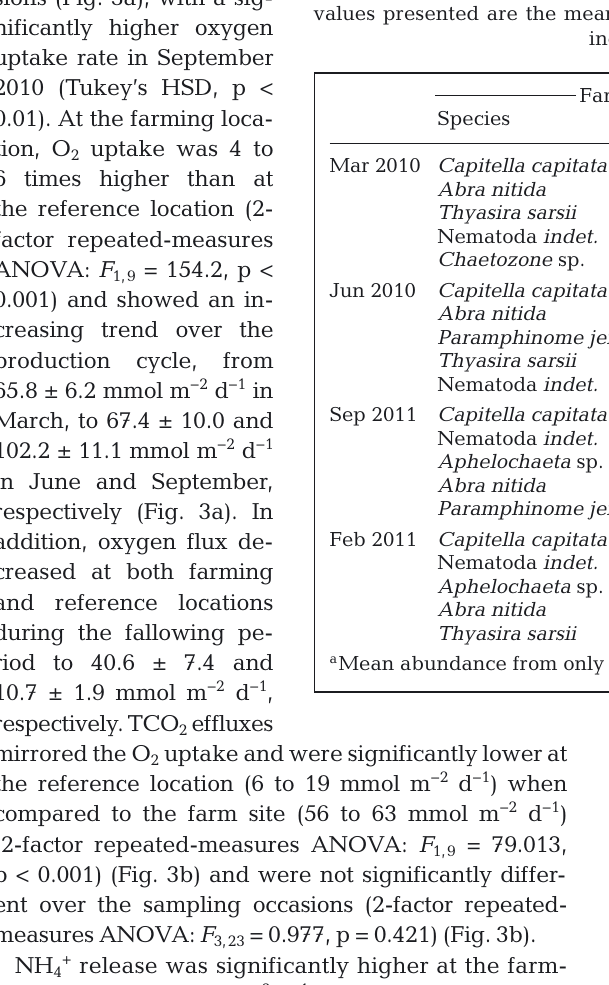
Table 6. Mean abundance (ind. m −2 ) of the 5 most dominant species recorded from replicate sediment cores from March 2010 to February 2011 at both sampling locations. Note that the